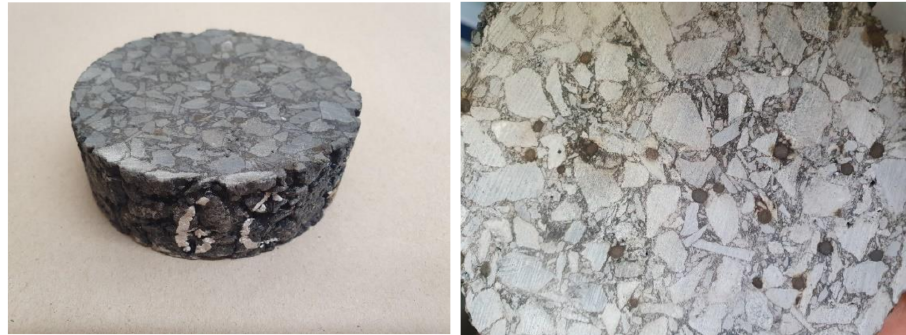
Figure 6. Image of 10 mm SMA—mix 6 containing 1.45% capsules in the